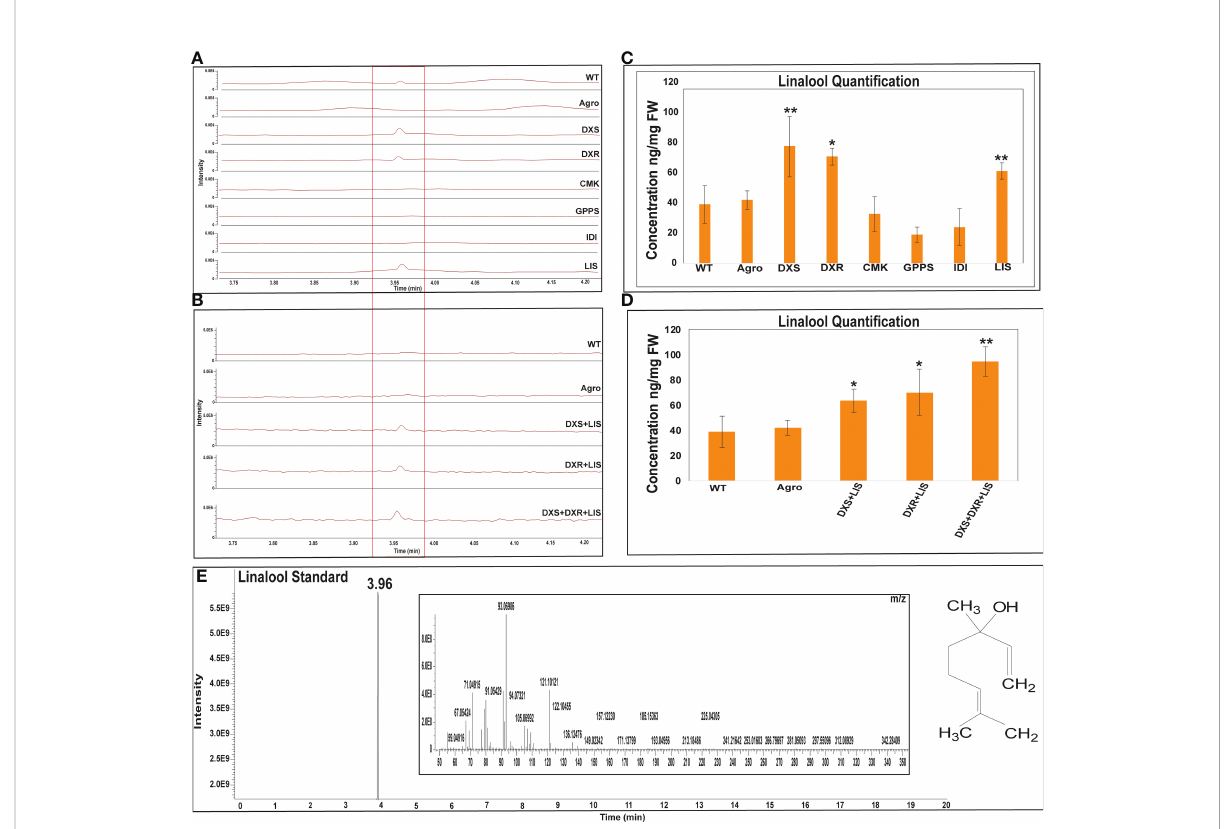
FIGURE 4 GC-Q-Oribtrap-MS linalool pro fi ling and quanti fi cation for individual and combinatorial approaches. (A, B) Individual and combinatorial linalool metabolite pro fi ling. (C, D) Individual and combinatorial costunolide quanti fi cation. (E) Linalool standard metabolite pro fi ling and m/z ions. Quanti fi cation of each bar represents the mean ± standard deviation (SD) of three independent experiments with three technical replicates. Statistical analyses (t-test) were conducted using SigmaPlot 12.5. For t-test analysis, the wild type values were used for construct comparisons. * indicates signi fi cant differences compared with the wild-type (*p < 0.05, **p <